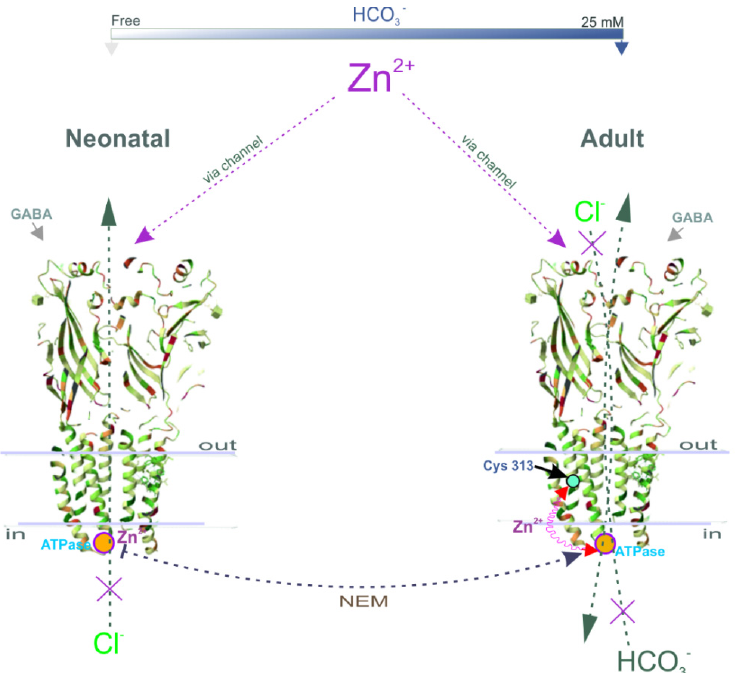
Figure 5. A hypothetical molecular mechanism for zinc inhibition of the GABA A R/ATPase function during neuronal development: ( left ) In neonatal neurons, Zn 2+ similar as NEM forms the inactive complex with ATPase center and inhibited the GABA A R-mediated Cl − efflux. ( right ) In mature neurons, Zn 2+ inhibits the GABA A R-mediated Cl − efflux. Modification of the Cys 313 thiol group by NEM activates the ATPase activity. Zinc eliminates the NEM effect, indicating their allosteric interaction. Architecture of GABA A R- β 3 cryst (two subunits from five are shown) and cysteine residue (C313) in M3 domain of β 3 subunit (Protein Data Bank).